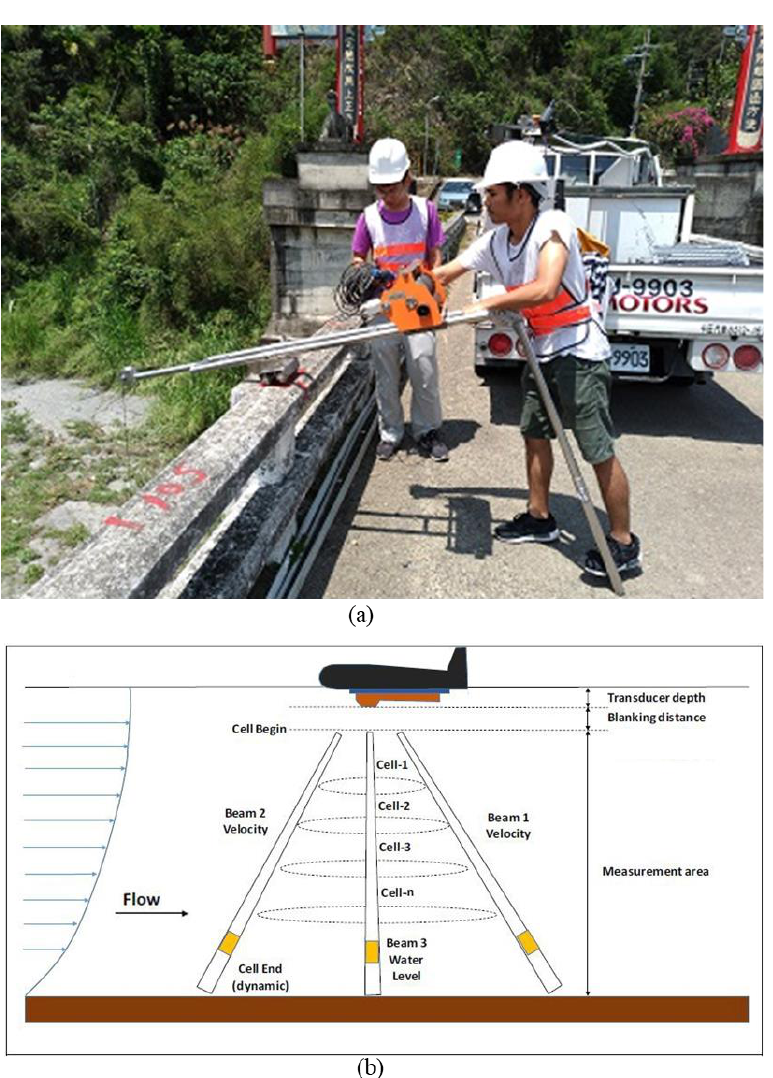
Figure 5. Instruments for measuring discharge. ( a ) A magnetic-inductive current meter and a SVR are used at the Guanyin Bridge; ( b ) A down-looking SW integrated with a sounding weight is used to measure the velocity profiles in the Longen Channel.